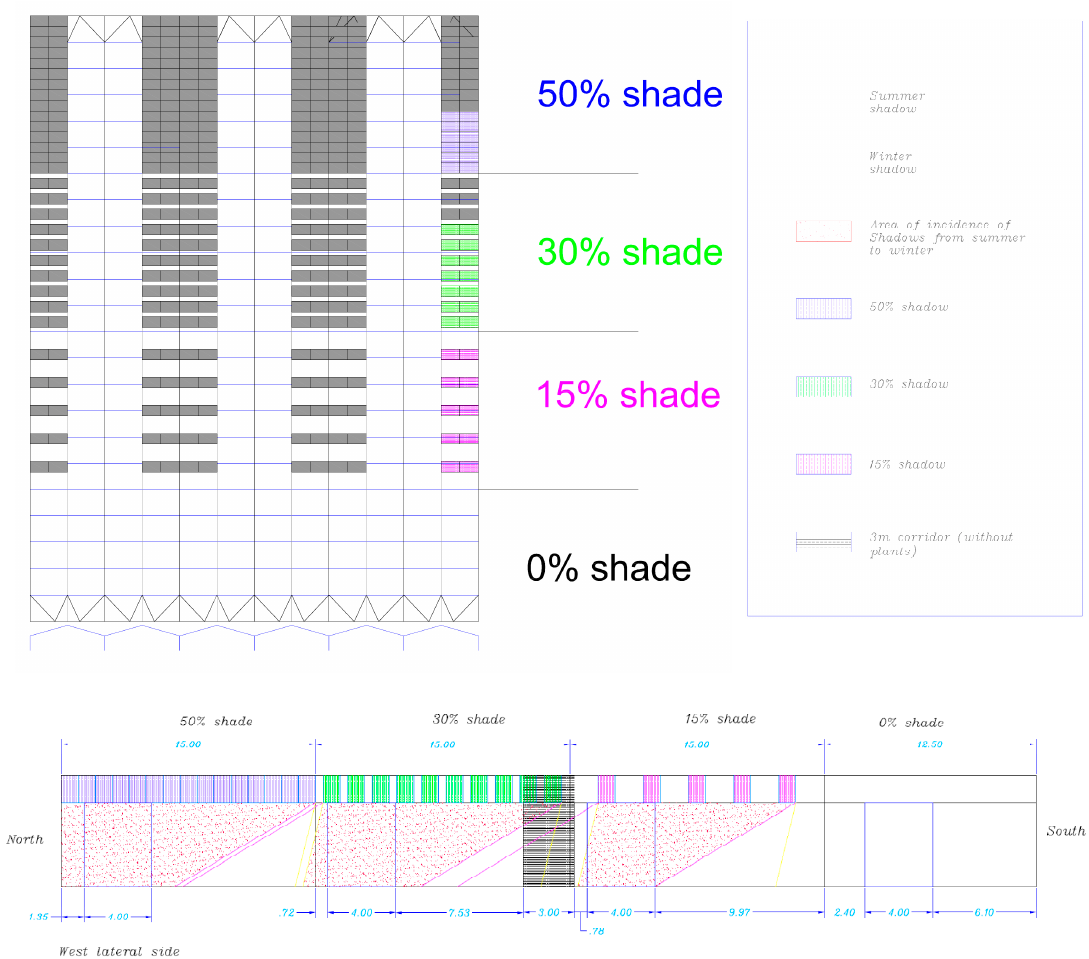
Figure 3. Location of photovoltaic modules and polyethylene sheets in the roof-top greenhouse (up). Projected shades inside the greenhouse of different shading treatments (down).